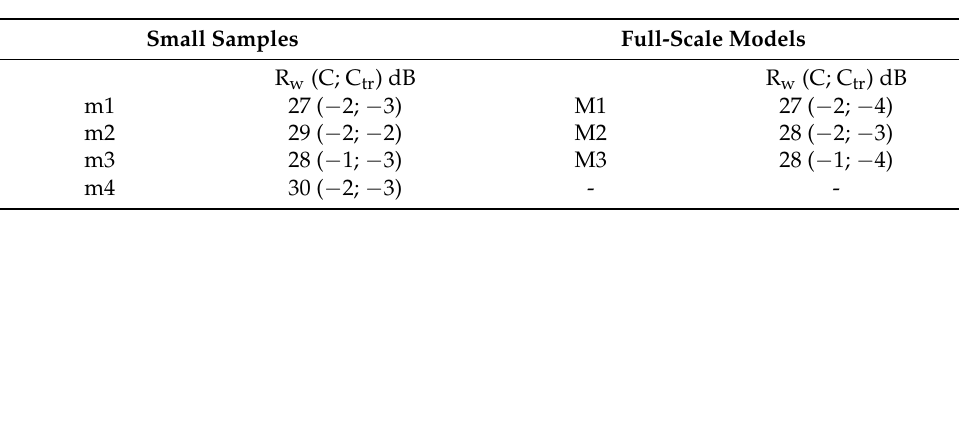
Table 2. Single number values for standalone composite panels, small samples (1390 mm × 2450 mm) and full-scale models (4190 mm × 2720